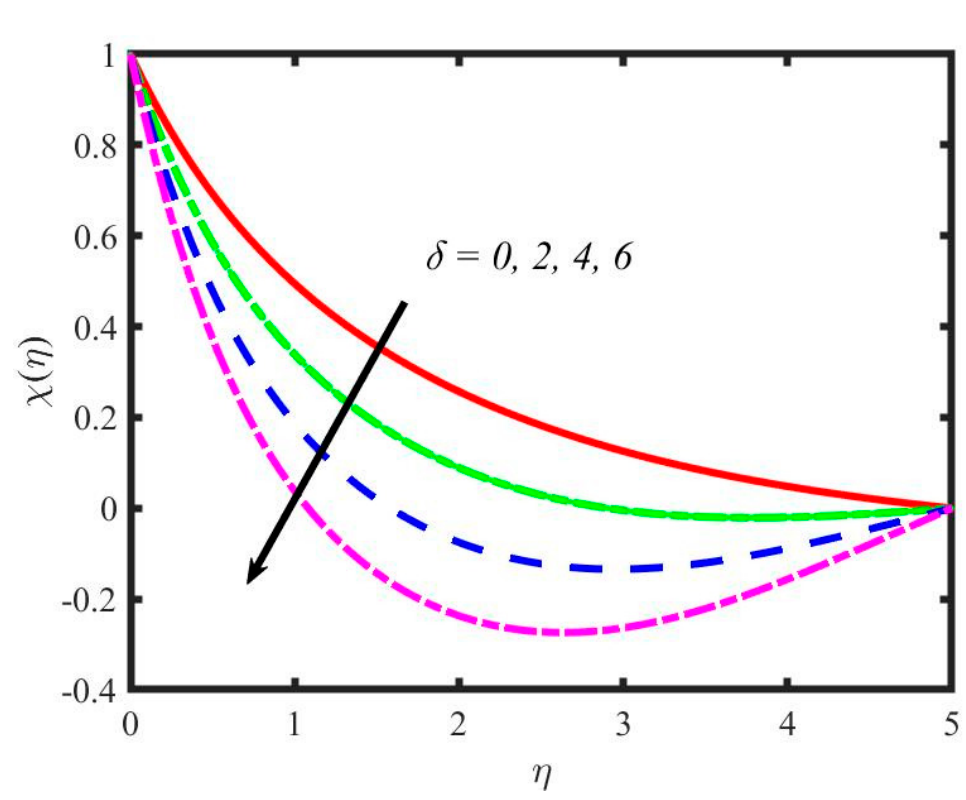
Figure 20. Variations in microorganism profile for microorganisms’ parameter.